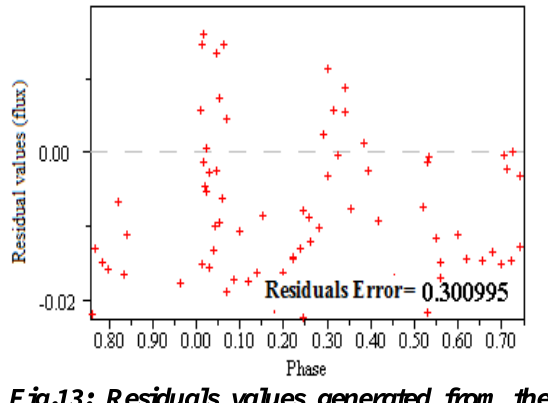
Fig.13: Residuals values generated from the synthetic and experimental data RT6 And, the number in the bottom right hand corner is the sum of squares of the residuals.